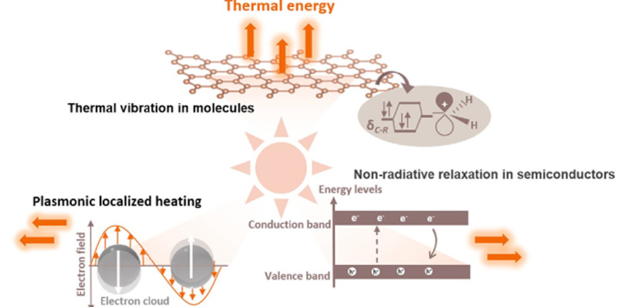
Figure 5. Schematic diagram of three photothermal effects (Reprinted/adapted with permission from Ref. [22]. Copyright 2022, copyright Elsevier).